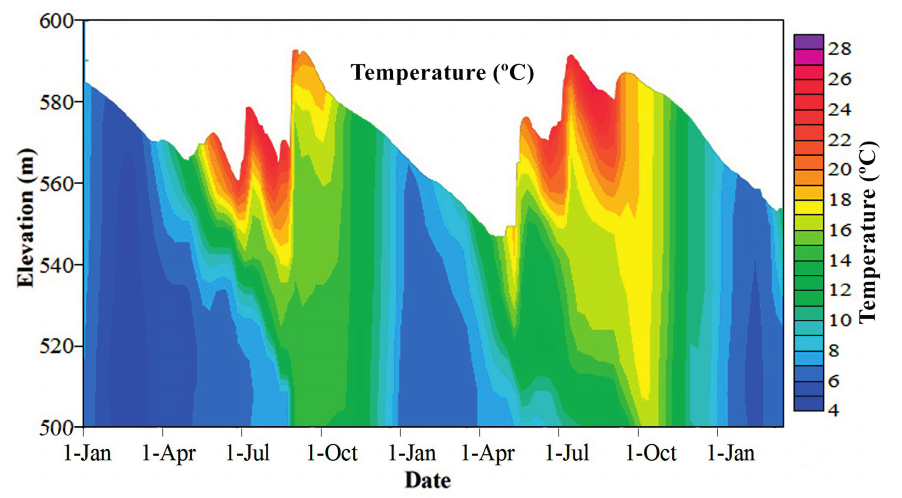
Figure 4. Vertical variation in temperature in the Heihe Reservoir from 1 January 2012 to 31 March 2014.